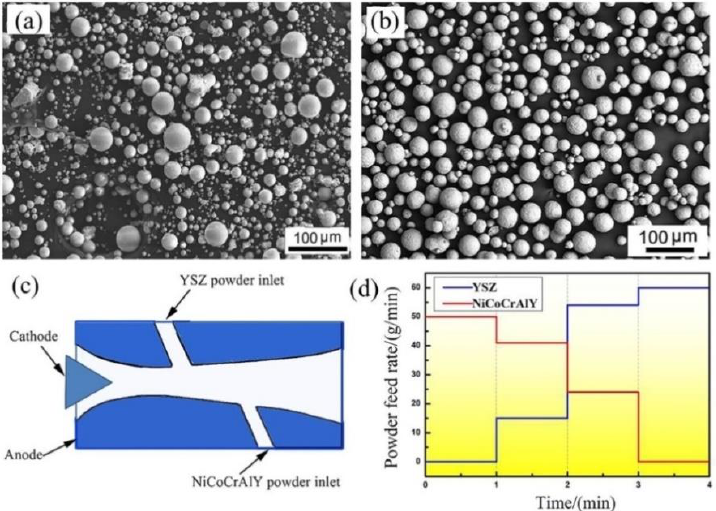
Figure 1. Original ( a ) NiCoCrAlY and ( b ) YSZ feedstock powder; ( c ) synchronous dual powder inlets and ( d ) powder feeding rate as a function of spraying time.